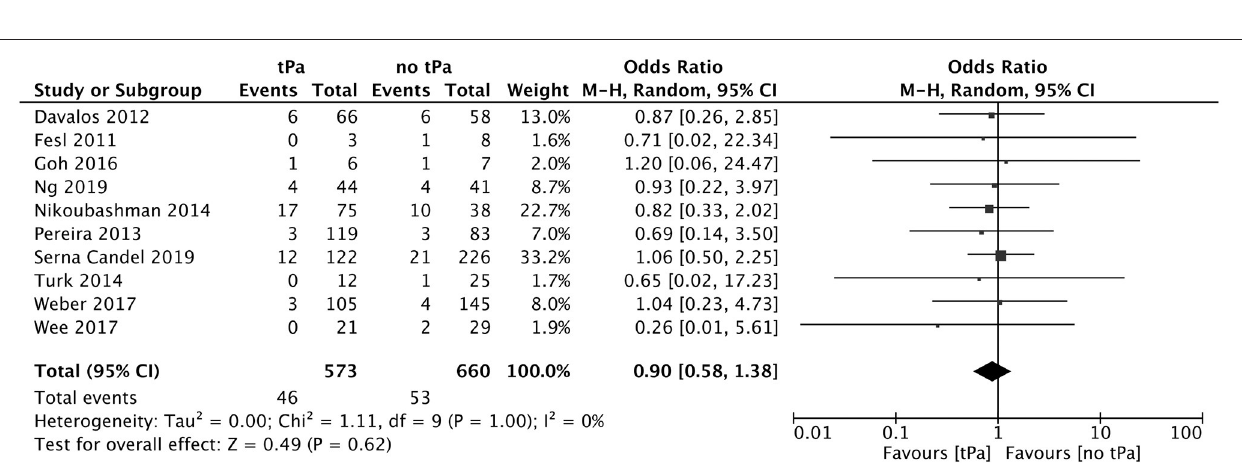
FIGURE 5 | Effect of IV tPA administration on subarachnoid hemorrhage following mechanical thrombectomy.